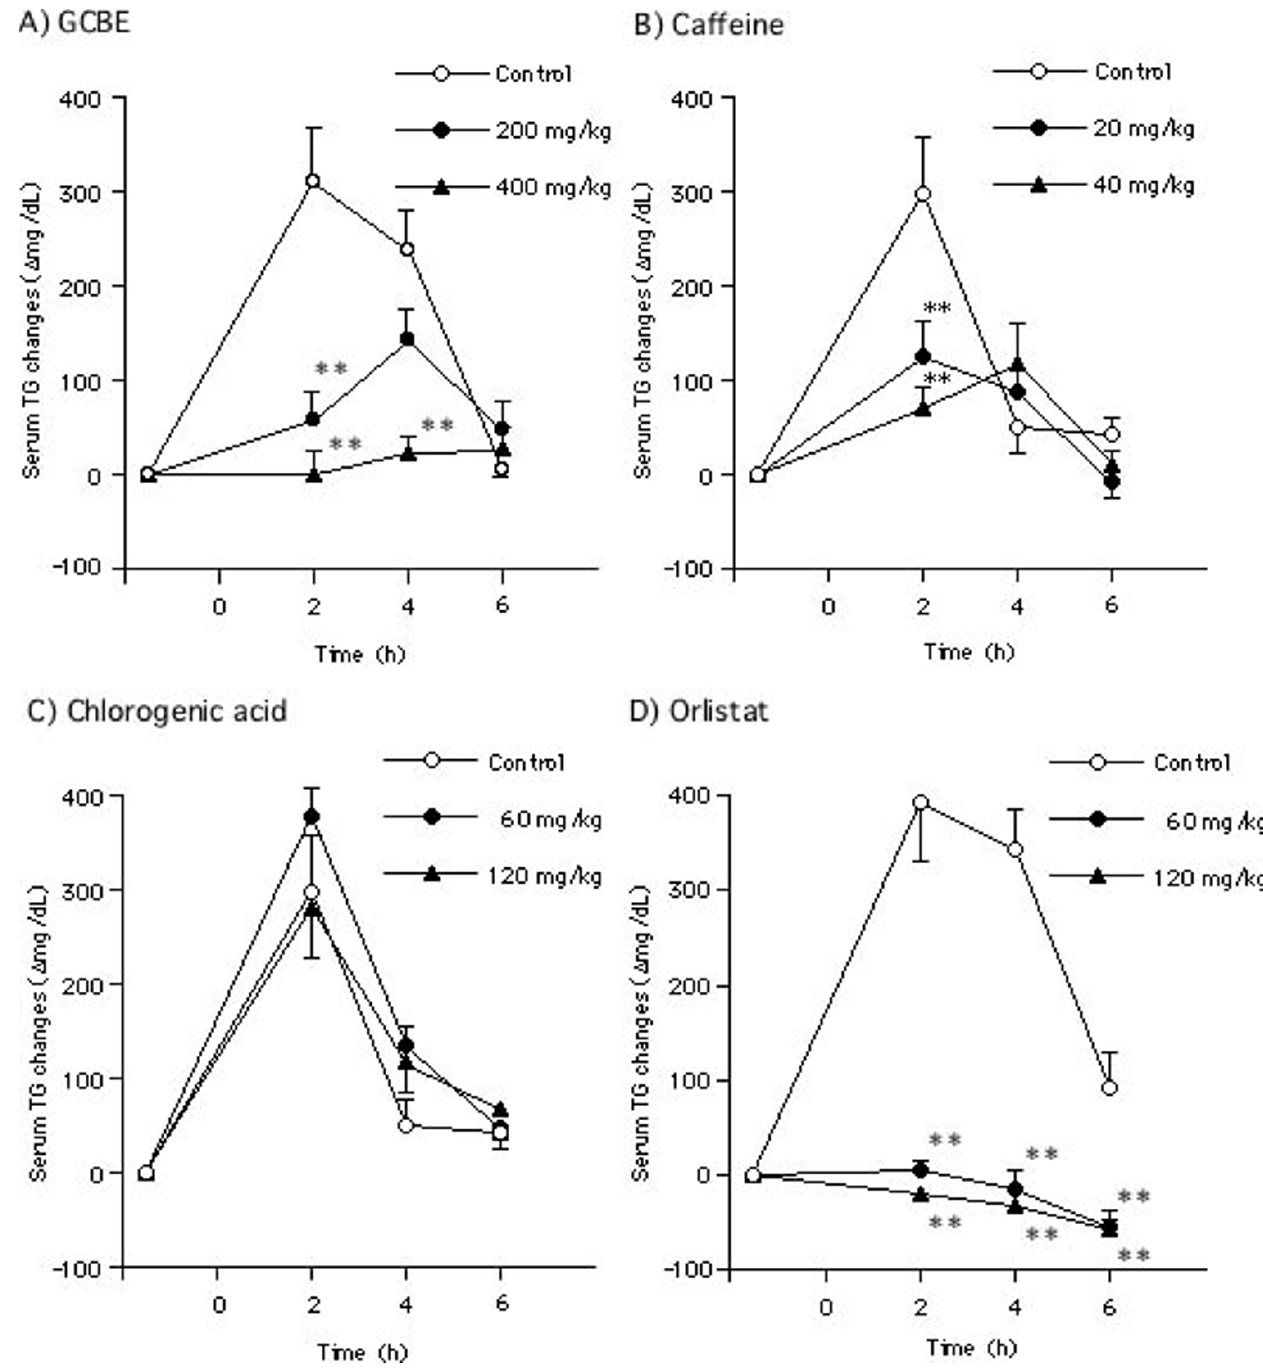
Figure 4 Inhibitory effects of GCBE, caffeine, chlorogenic acid and orlistat on serum TG elevation in olive oil-loaded mice . An initial blood sample was collected from each mouse, and each sample was orally administered 30 min later. After 1 h, olive oil was orally administered and a blood sample was collected every 2 h. Symbols represent the mean ± SE of 6 mice. The double asterisks denote a significant difference from the control group, **: p <